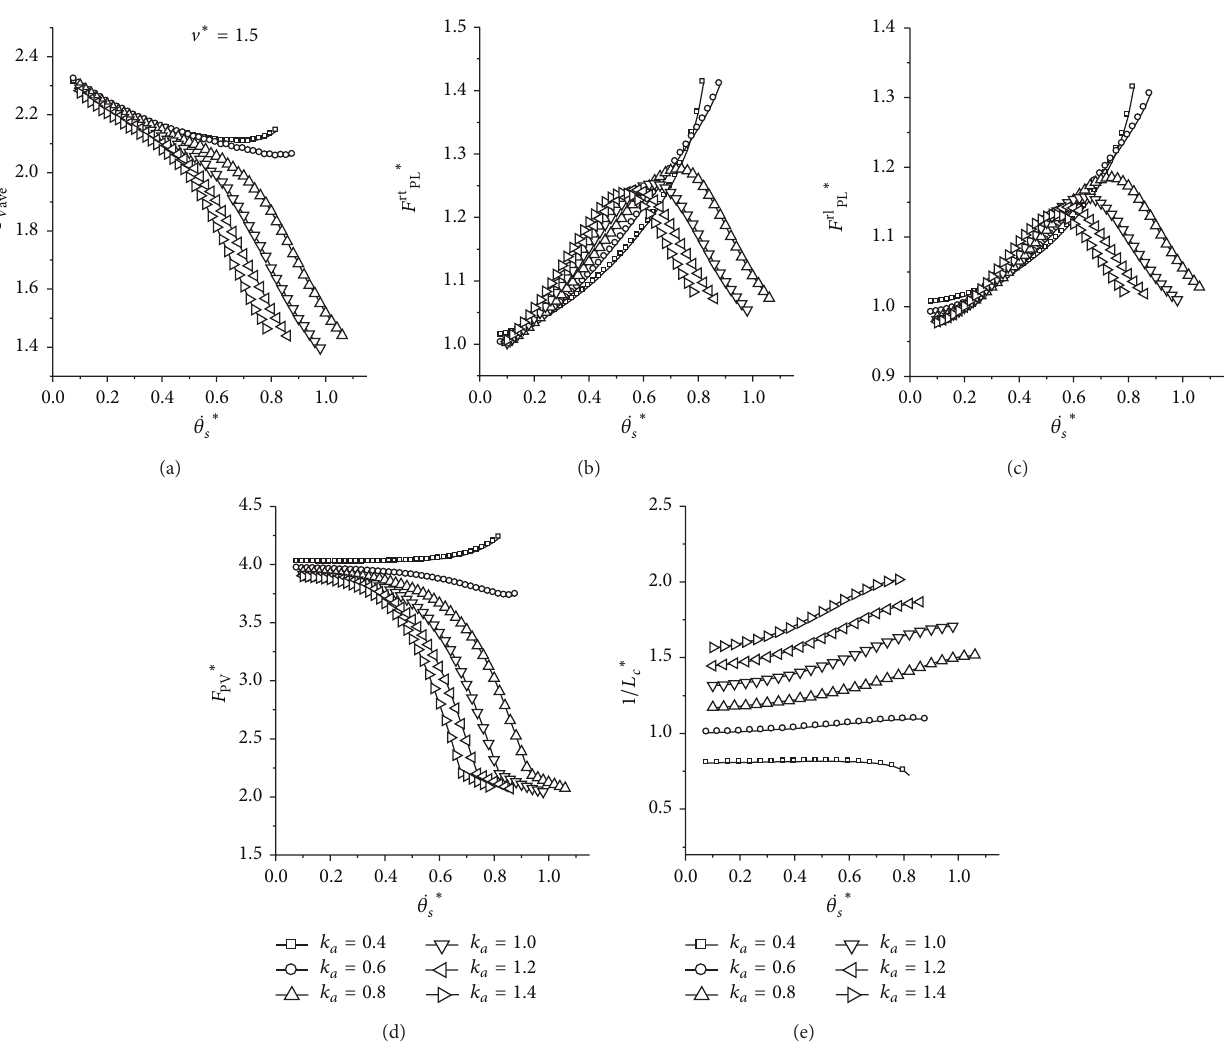
Figure 5: The influence of different 𝑘 𝑎 on the dynamics. (a) Average dimensionless vertical force; (b) peak force of the rear trailing leg; (c) peak force of the rear leading leg; (d) peak ground reaction force; (e) indicator of the metabolic cost of transport (1/ 𝐿 𝑐∗ ). Initial conditions: = 1 , 𝜇 = 0.05 , 𝑝 = 1.0 , and V ∗ = 1.5 . 𝑦 ∗ 𝑠